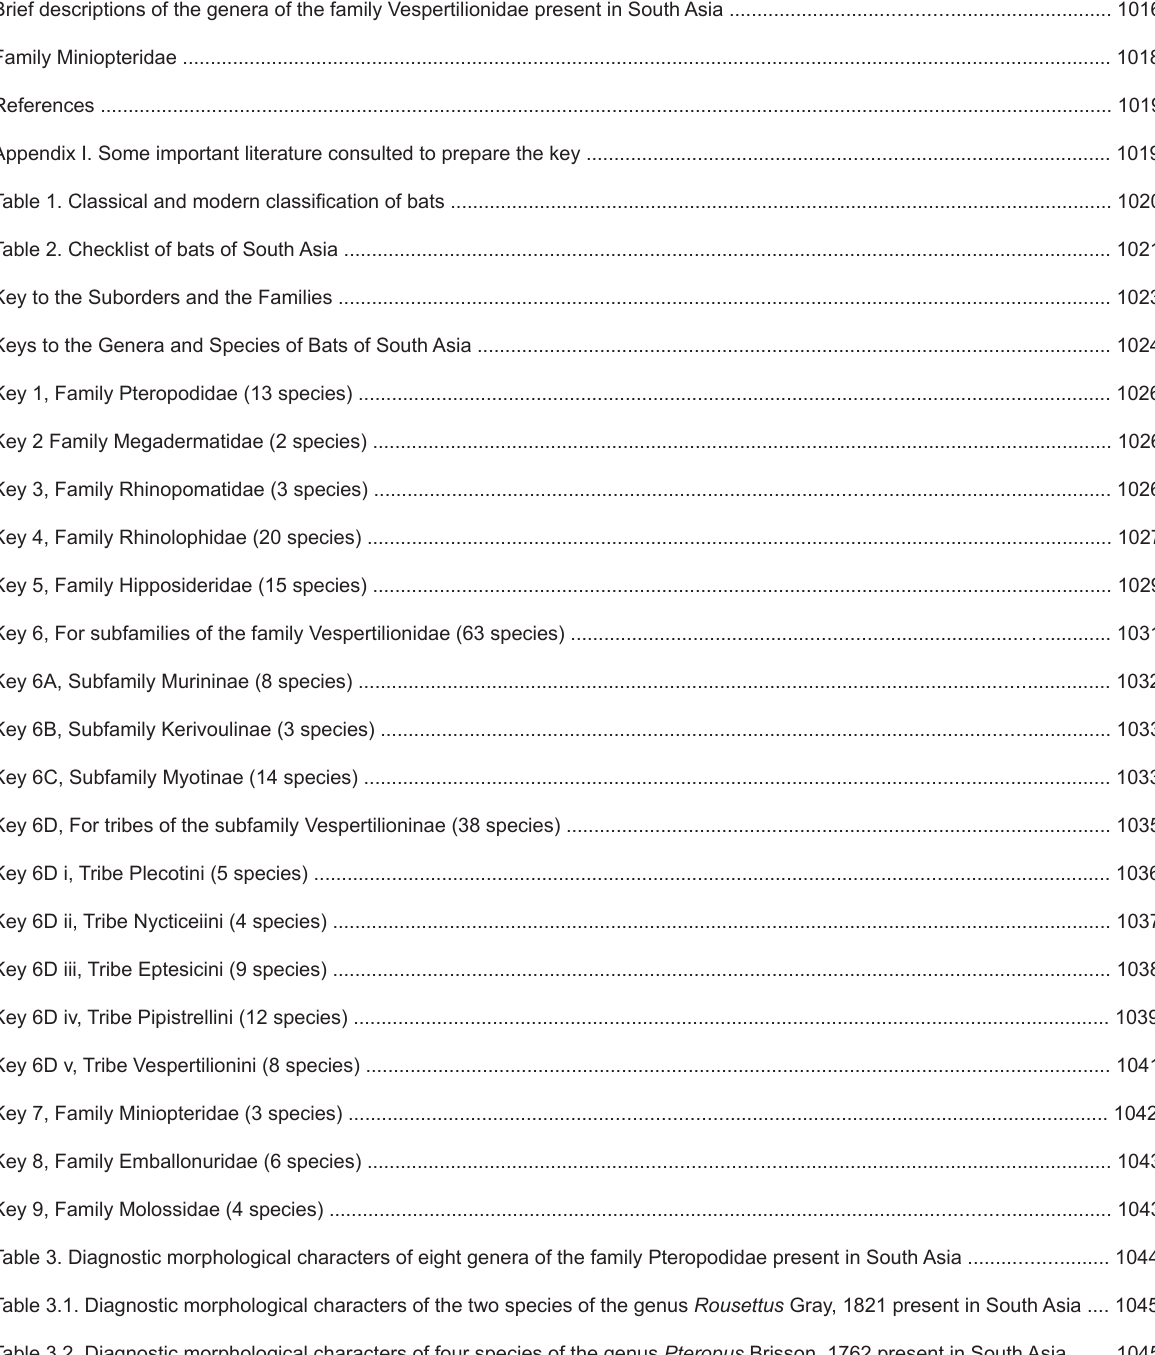
Table 3. Diagnostic morphological characters of eight genera of the family Pteropodidae present in South Asia ......................... 1044 Table 3.1. Diagnostic morphological characters of the two species of the genus Rousettus Gray, 1821 present in South Asia .... 1045 Table 3.2. Diagnostic morphological characters of four species of the genus Pteropus Brisson, 1762 present in South Asia ....... 1045 Table 3.3. Diagnostic morphological characters of the two species of the genus Cynopterus Cuvier, F., 1824 present in South Asia ... ......................................................................................................................................................................................................... 1046 Table 3.4. Diagnostic morphological characters of the species of the genera Megaerops Peters, 1865; Latidens Thonlongya, 1972; Sphaerias Miller, 1906; Eonycteris Dobson, 1873; and Macroglossus Cuvier, F., 1824 present in South Asia .............................. 1046 Table 4. Diagnostic morphological characters of the genera of the families Rhinopomatidae, Emballonuridae, Megadermatidae and Rhinolophidae present in South Asia .............................................................................................................................................. 1047 Table 4.1. Diagnostic morphological characters of the three species of the genus Rhinopoma E. Geoffroy, 1818 present in South Asia .................................................................................................................................................................................................